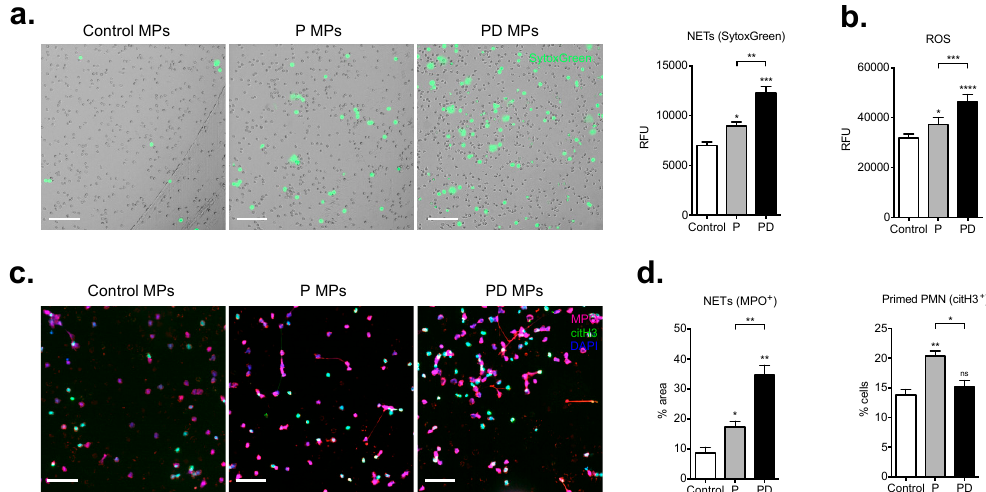
Figure 6. Postpartum NET formation is triggered by circulating microparticles. ( a ) In vitro NET formation detected microscopically in a 3 h time course with SytoxGreen DNA binding dye after a 1 h pretreatment with equal amounts of microparticles isolated from pregnancy plasma and 48 h postpartum plasma and SytoxGreen fluorimetry of in vitro extracellular DNA release by control neutrophils (right panel) after 3 h treatment with pregnancy and post-delivery microparticles. ( b ) Measurement of ROS generation by control neutrophils in response to pregnancy and postpartum derived microparticles by DCFH-DA detection. ( c ) Fluorescent immunostainings for MPO (red), citH3 (green) and DNA (blue) and ( d ) morphometric assessment of NETs (MPO positive) and pro-NETotic (citH3 positive) neutrophils under the same experimental setup. Magnification: 20×; Scale bars: 50 μ m. P: pregnancy; PD: post-delivery. Data are presented as mean ± SEM. * p < 0.05, ** p < 0.01, *** p < 0.001, **** p < 0.0001 (one-way anova followed by bonferroni’s multiple comparison post-test). All experiments were performed at least 3 times with consistent results.